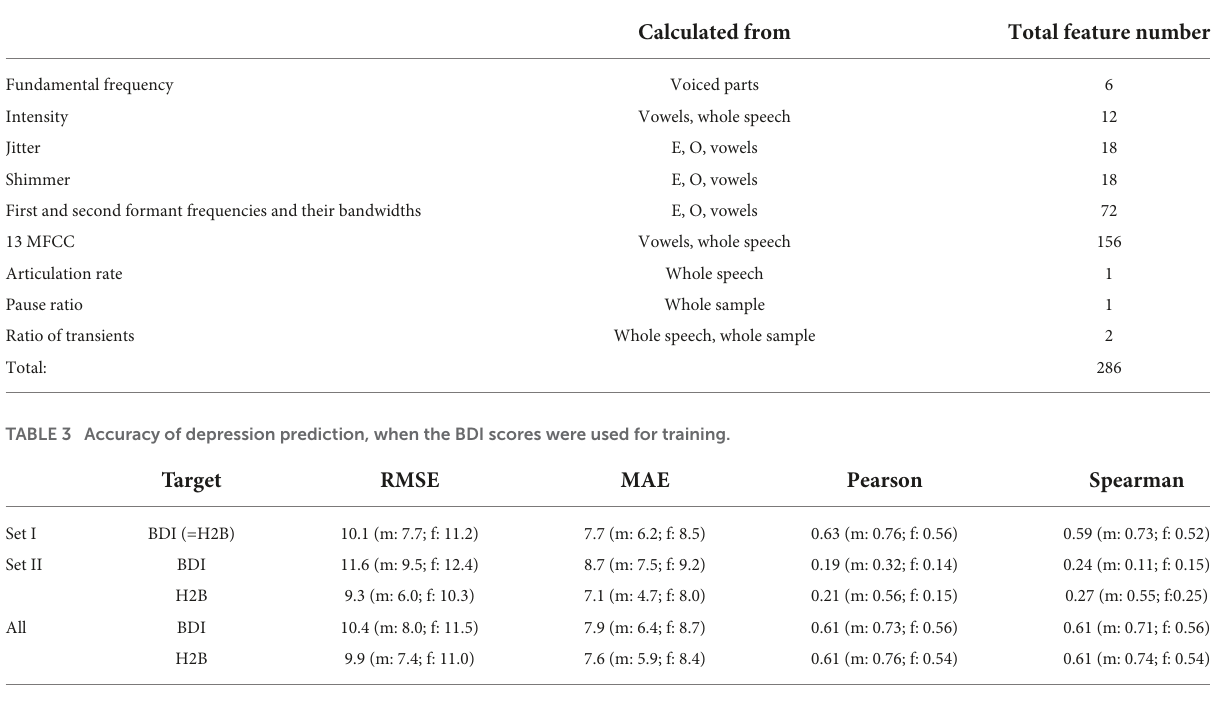
TABLE 2 The used descriptive features calculated from LLDs.